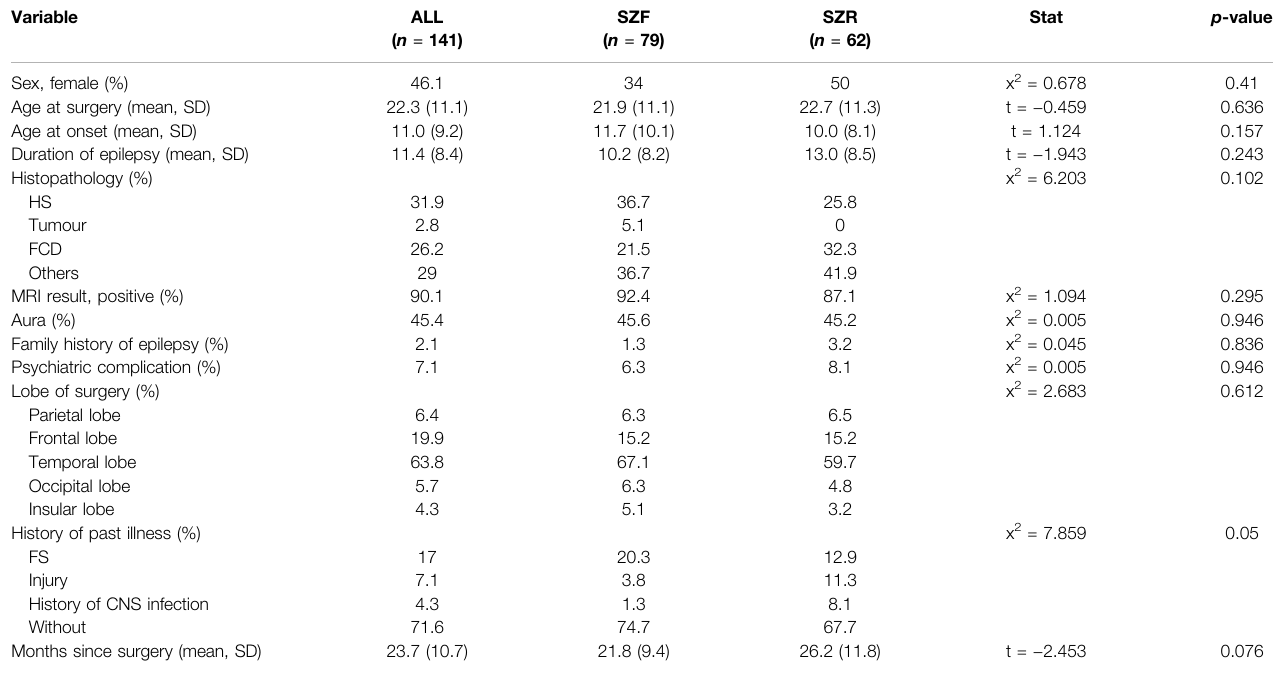
TABLE 2 | Baseline characters of patients. Variable